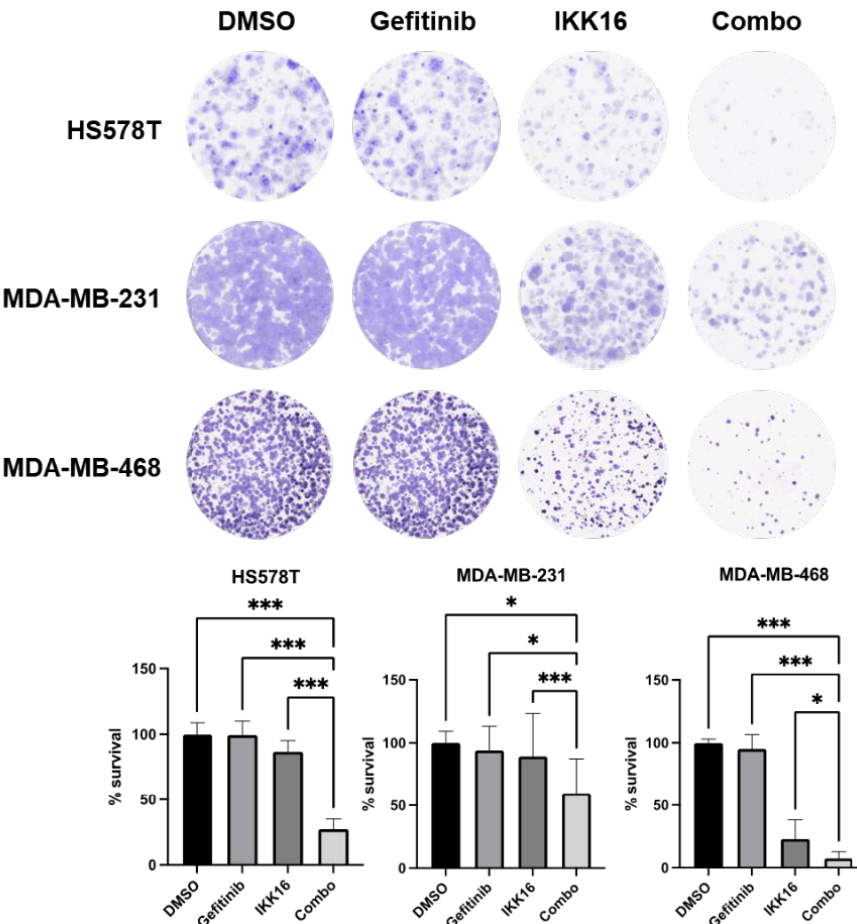
Figure 3. The Gefitinib+IKK16 combination reduced the survival of TNBC cells. HS578T, MDA-MB- 231, and MDA-MB- 468 cells were treated with 10 μM gefitinib, 2.5 μM IKK16, or the combination of 10 μM gefitinib and 2.5 μM IKK16 (Combo) for 24 h and cultivated for 10 – 14 days in normal growth media. The colonies were stained as described in the Materials and Methods. Representative images are shown from three independent experiments performed in triplicates. *, p < 0.05; ***, p < 0.001.